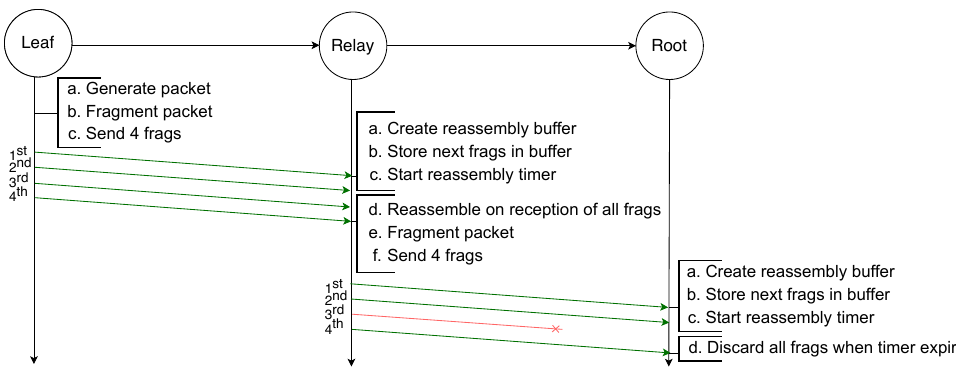
Figure 3. Failed transmission of a fragmented packet with RFC 4944 FF over two hops: the loss of one fragment makes the reassembly of the packet